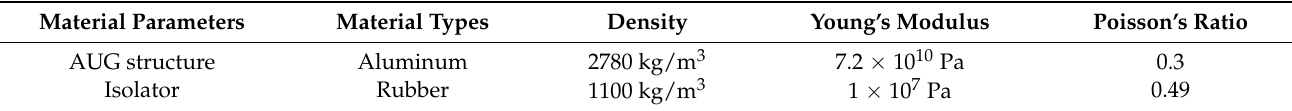
Figure 14. ( a ) The finite element model of the AUG, ( b ) the meshing of the AUG, and ( c ) the acoustic–structure coupling finite element model of the AUG. Table 1. Material parameters of the finite element